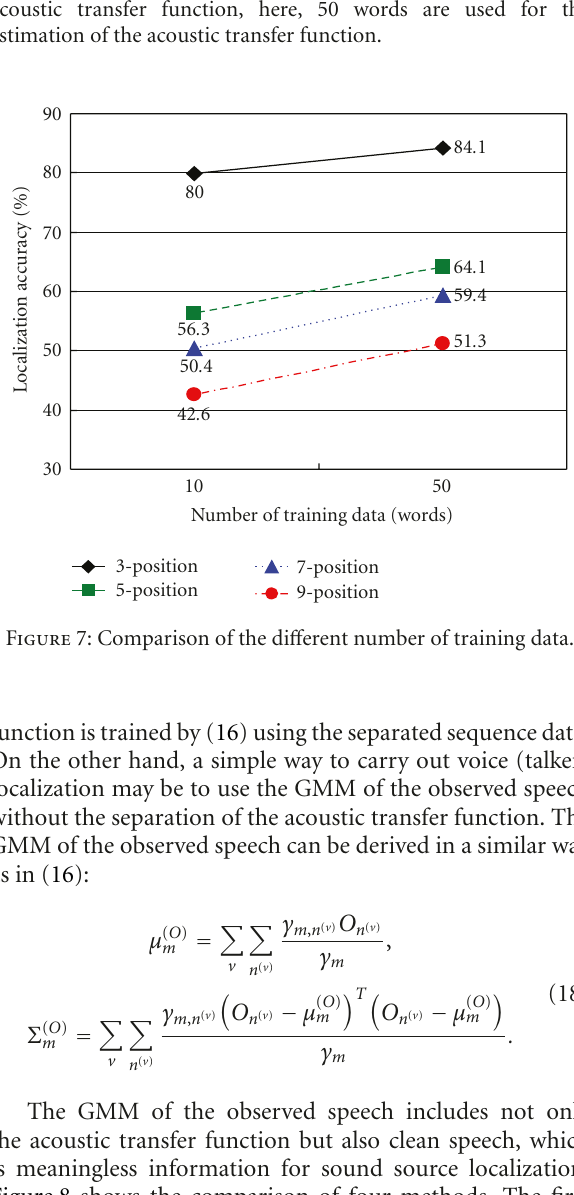
Figure 5: Impulse response (90 degrees, reverberation time: 300 milliseconds).